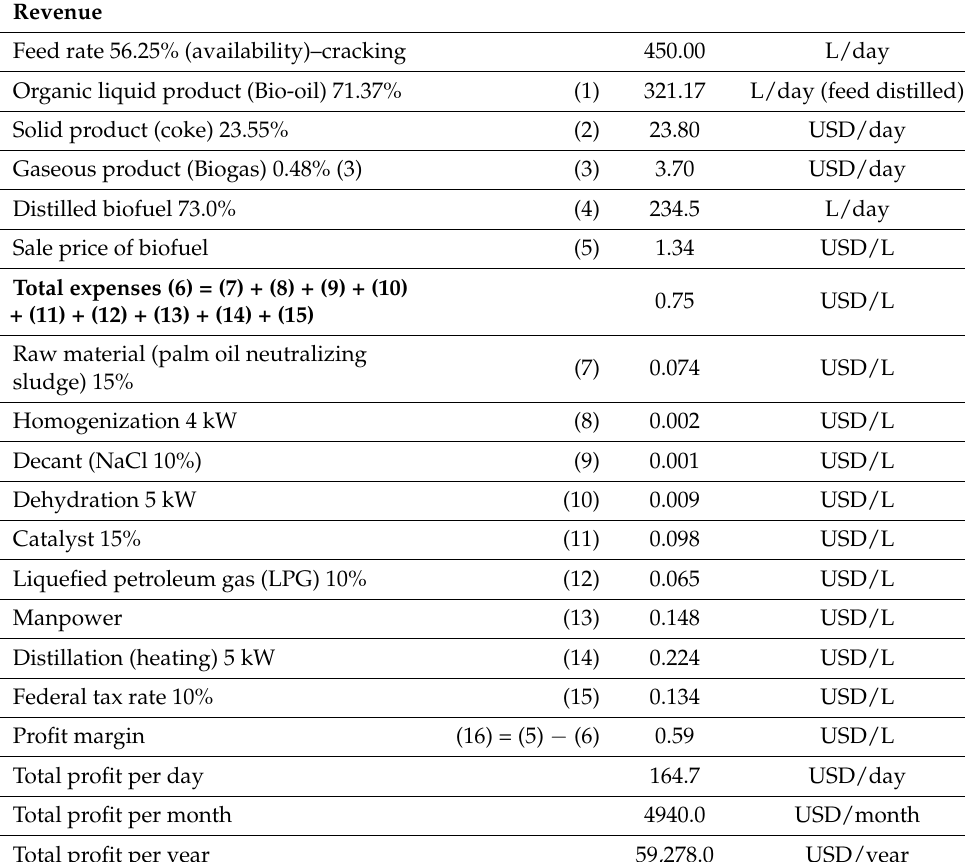
Table 10. Revenues and expenses using palm oil neutralization sludge as raw